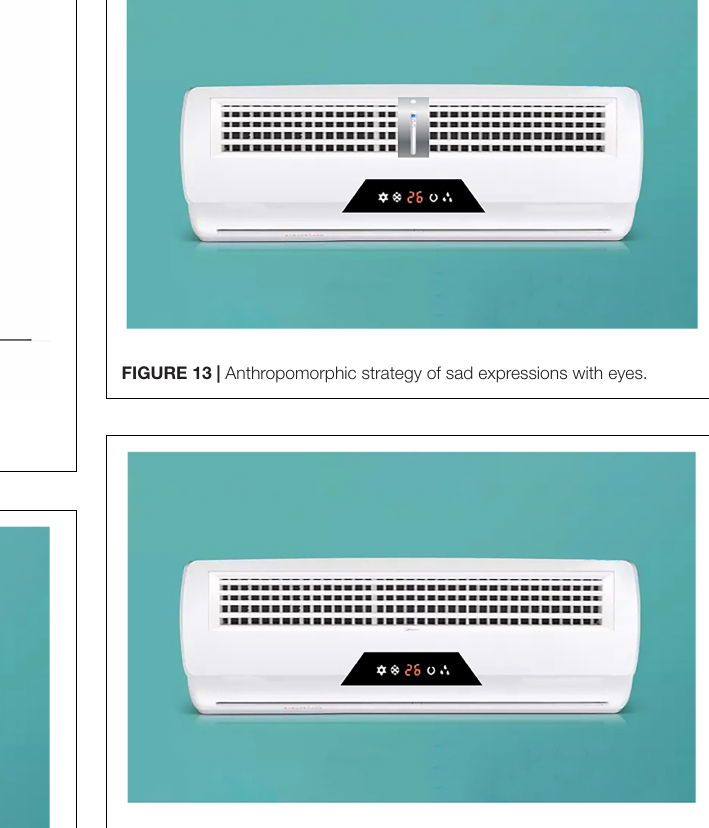
FIGURE 14 | Anthropomorphic strategy of sad expressions without eyes.